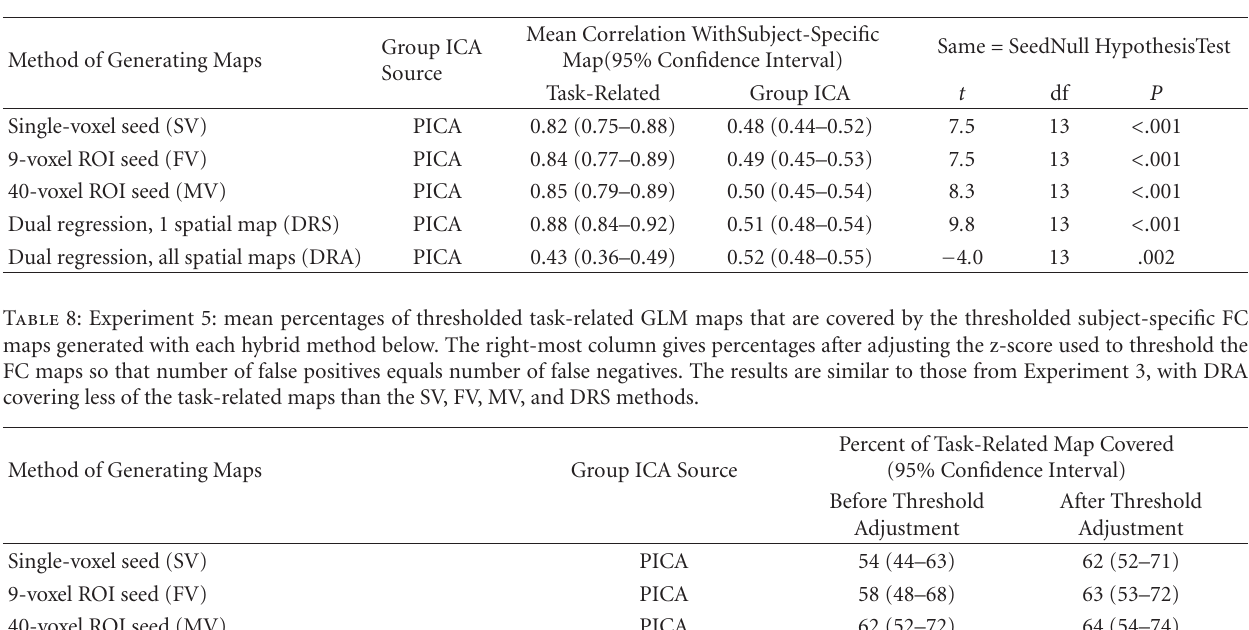
Table 7: Experiment 5: mean correlations of subject-specific FC spatial maps with (1) the task-related GLM map for the same subject (“Task- Related” column) and (2) the group IC of interest (“Group IC” column). Results of a paired t -test comparison of the mean correlations are shown in the rightmost columns. These results were based on a group ICA that produced 30 components.